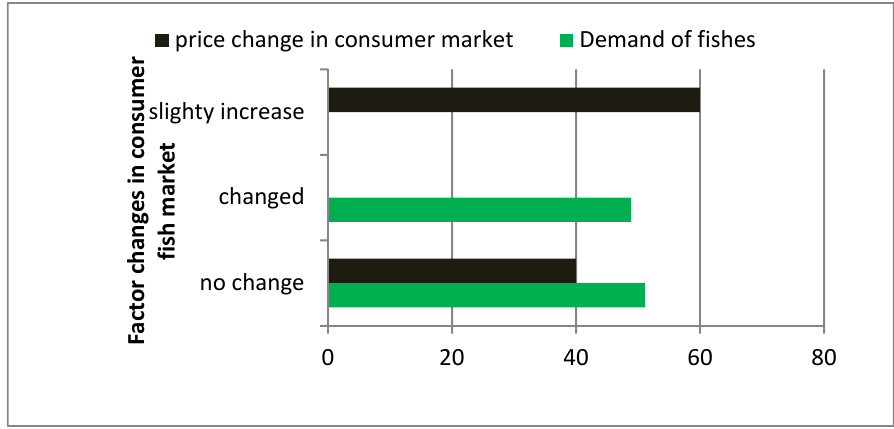
Figure 5. Perception of impacts of COVID-19 on consumer fish market.